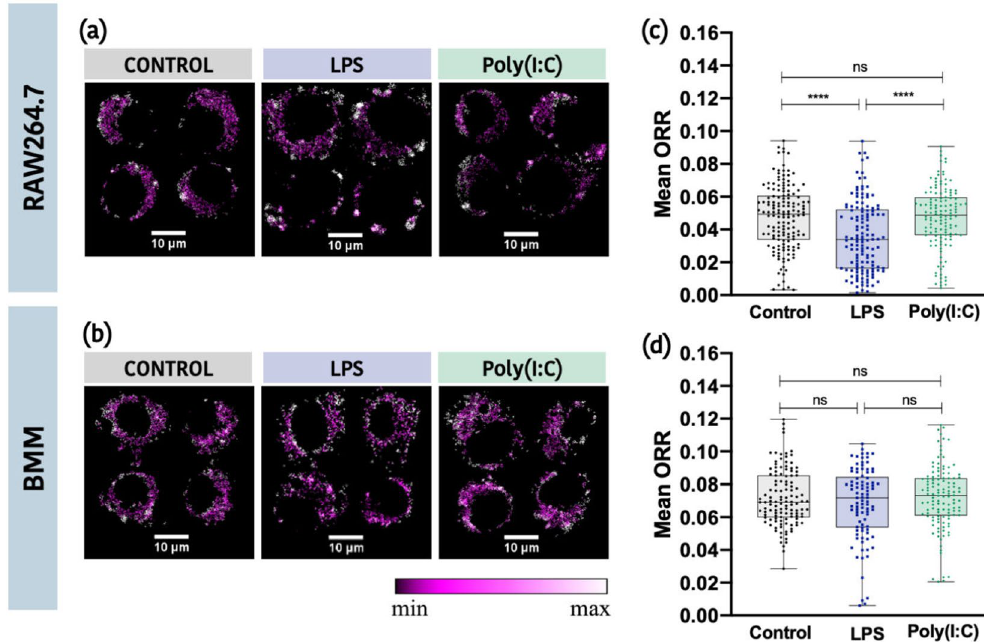
Figure 2. Mean ORR is significantly lower in LPS treated cells than that observed in control and Poly(I:C) treated cells for RAW264.7 cells but not BMM. Representative ORR images of cells from different regions of interest for control, LPS-treated and Poly(I:C)-treated for RAW264.7 cells ( a ) and BMM cells ( b ). Mean ORR values for control, LPS, and Poly(I:C) treated cells for RAW264.7 cells ( c ) and BMM cells ( d ) (*p < 0.05, **p < 0.01, ***p < 0.001, ****p <